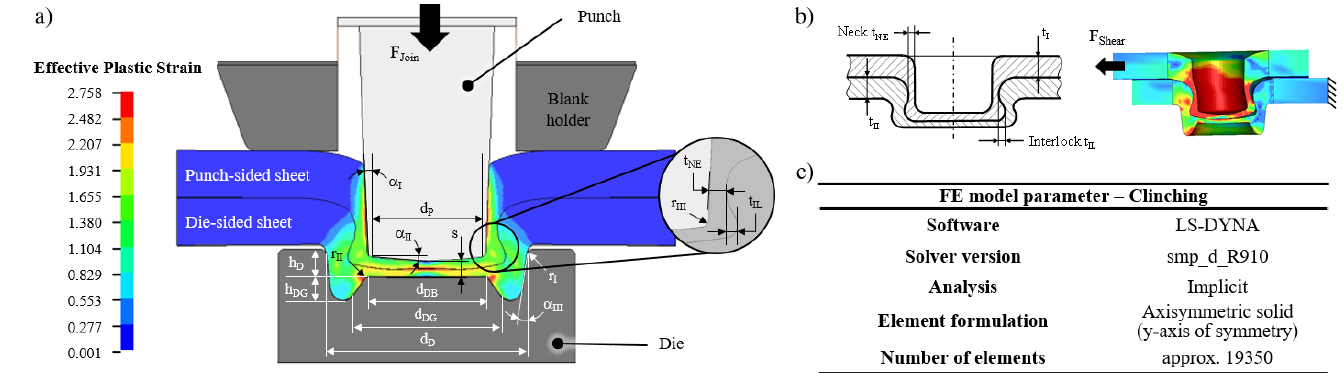
Figure 2. Illustration of the clinch joining process ( a ), resulting joint properties ( b ) and FE model parameters ( c